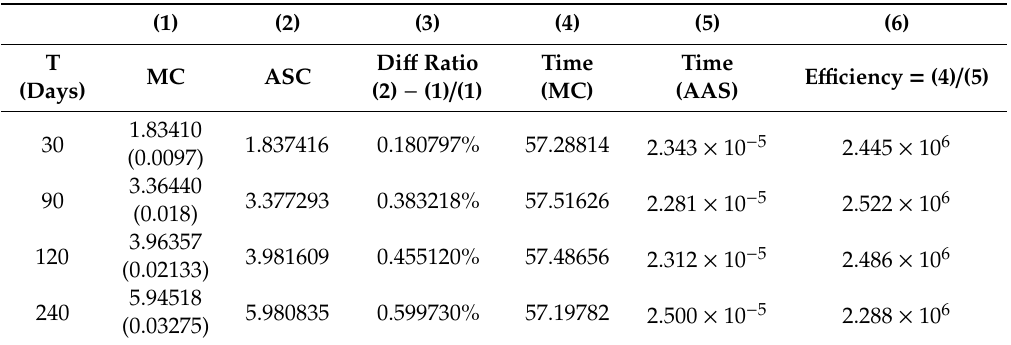
Table 2. Comparison of the analytical solutions of the proposed FSAO and the Monte Carlo method.